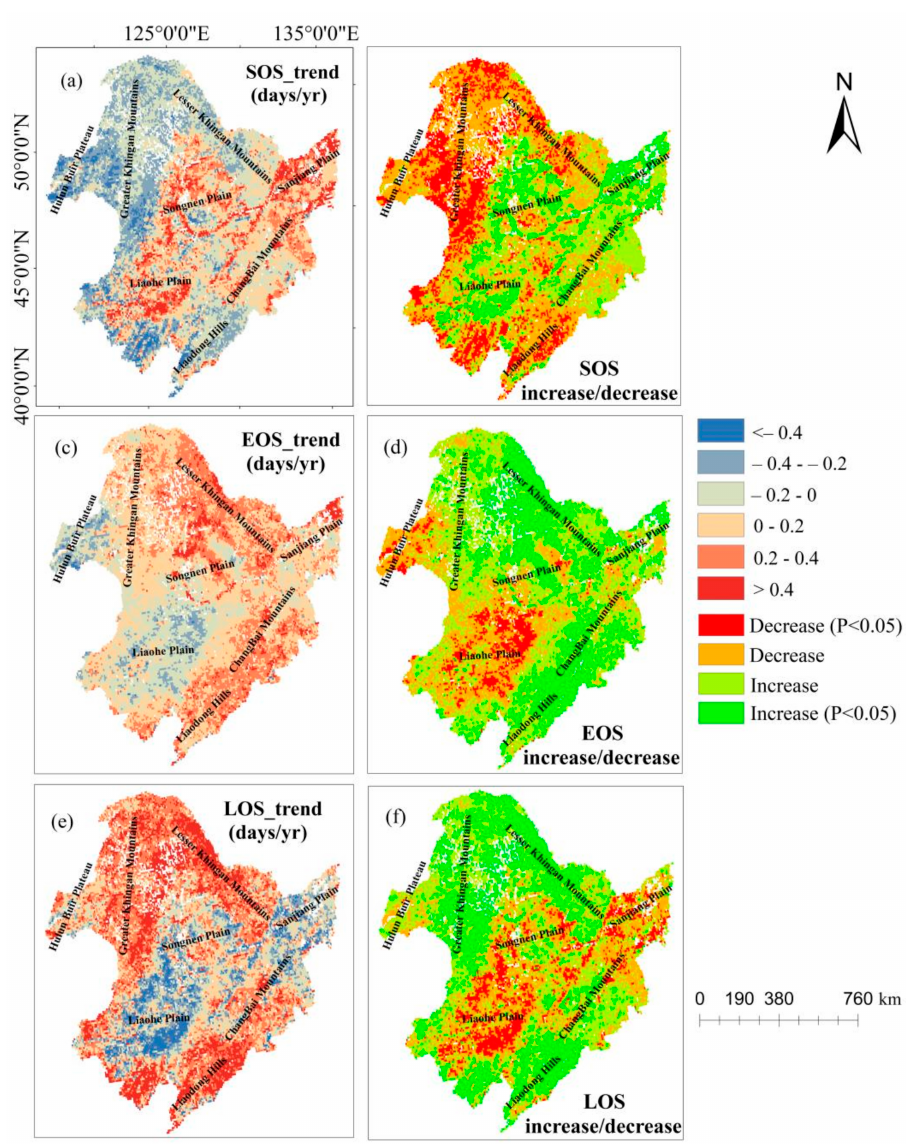
Figure 5. Spatial distribution of the variations in the vegetation phenological parameters of northeast China during 1982–2014 and statistical test results at 5% significance level. ( a , c , e ) present changes in SOS, EOS, and LOS, respectively (days year − 1 ). ( b , d , f ) present significant changes (5% significance level) in the start of the growing season (SOS), the end of the growing season (EOS), as well as the length of the growing season (LOS),